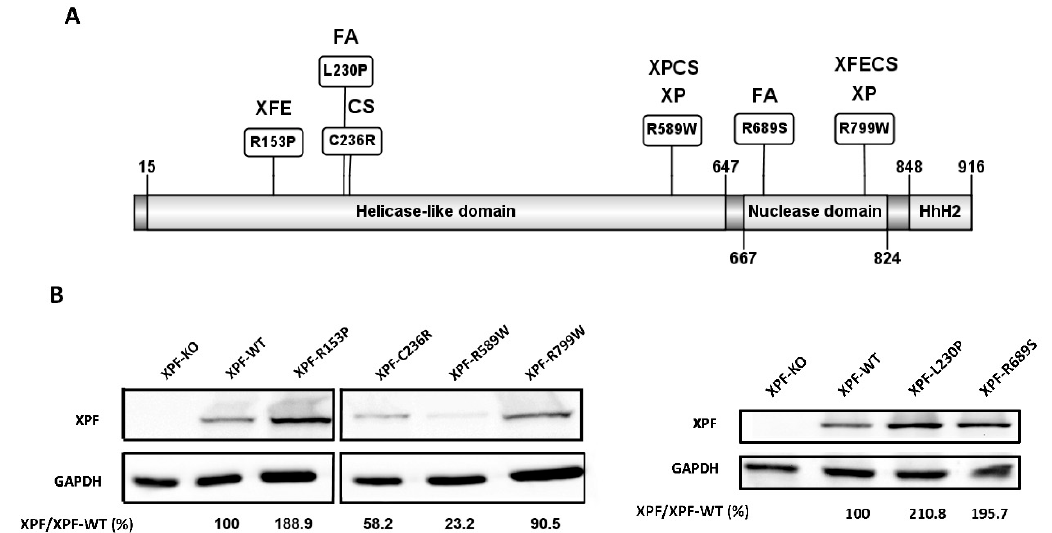
Figure 1. ( A ) Schematic view of the XPF domains with the selected mutations and the diseases found in patients. The patient XPCSCD had an allele with C236R and the other with R589W. R799W mutation found in homozygosis in XP was also found in a cohort of patients with XFE sharing CS features. This figure was created with a protein designing software from [44]. XP: Xeroderma Pigmentosum; CS: Cockayne Syndrome; XPCSCD: Xeroderma Pigmentosum Cockayne Syndrome combined disease; XFE: Segmental Progeria. ( B ) Western Blot (WB) levels of each single XPF mutant transduced cell line. The two WB are split by spatial reasons. Levels of XPF proteins are normalized to GAPDH expression levels and expressed as a percentage relative to the exogenous XPF-Wt. GAPDH is used as a loading control. 311 Cell lines expressing the different XPF variants were tested for sensitivity to UVC irradiation. For